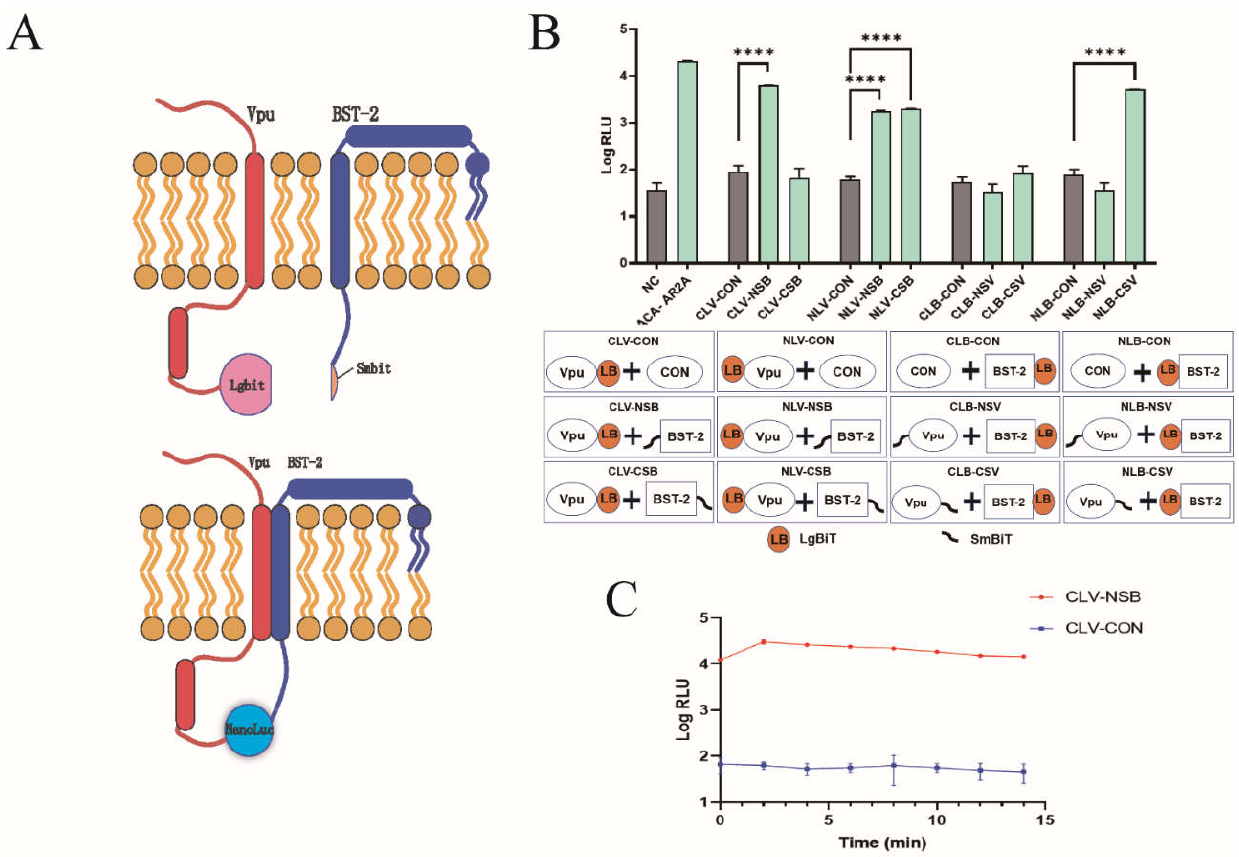
Figure 1. Development of the NanoBiT assay for detecting Vpu-BST-2 interaction. ( A ) Illustrations of the NanoBiT assay to monitor Vpu-BST-2 interaction. ( B ) Optimization of Vpu and BST-2 plasmid combinations. HEK293T cells were co- transfected with eight plasmid combinations as well as their respective controls. Two days later, the fluorescence values were measured to find the combination with the highest luciferase activity. ****, p < 0.0001 vs. control group. (NLB: pBiT1.1- N-bst-2; NSB: pBiT2.1-N-bst-2; CLB: pBiT1.1-C-bst-2; CSB: pBiT2.1-C-bst-2; NLV: pBiT1.1-N-vpu; NSV: pBiT2.1-N-vpu; CLV: pBiT1.1-C-vpu; CSV: pBiT2.1-C-vpu; NC: negative control; CON: SmBiT vector control; ACA-AR2A: PRKACA: PRKAR2A pair was used as a constitutive positive control) ( C ) HEK293T cells were co-transfected with plasmids CLV and NSB. Two days later, after adding the substrate, the detection was carried out every 2 min to determine the optimal timepoint of NanoBiT assay. Values presented are the mean ± standard deviation (SD) of three replicates. All experiments were performed five times.